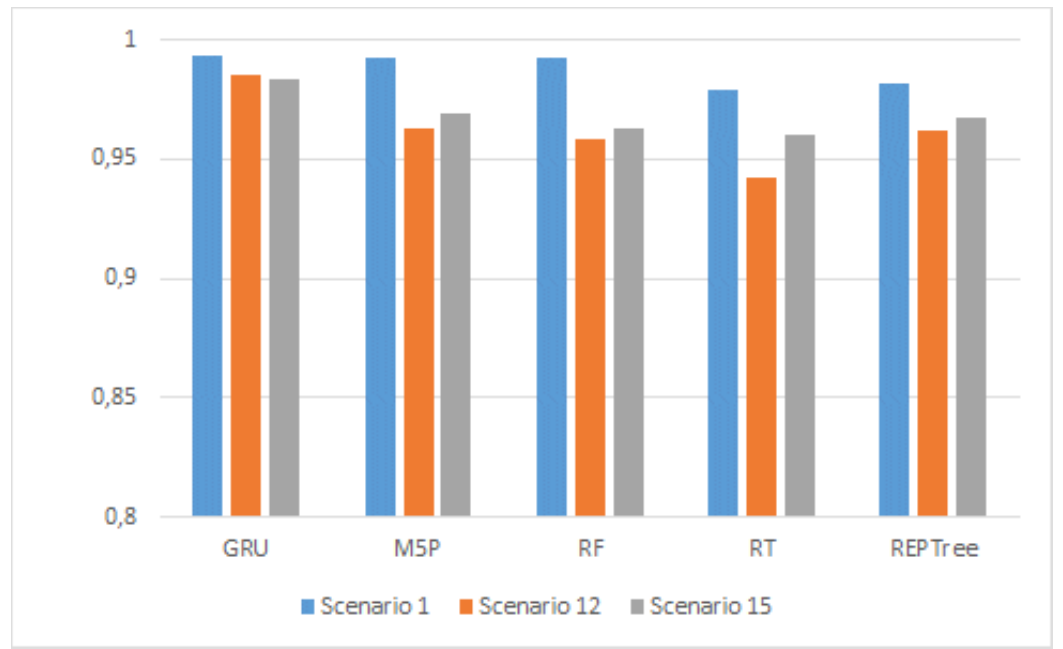
Figure 11. Comparison of R values of models according to scenarios.